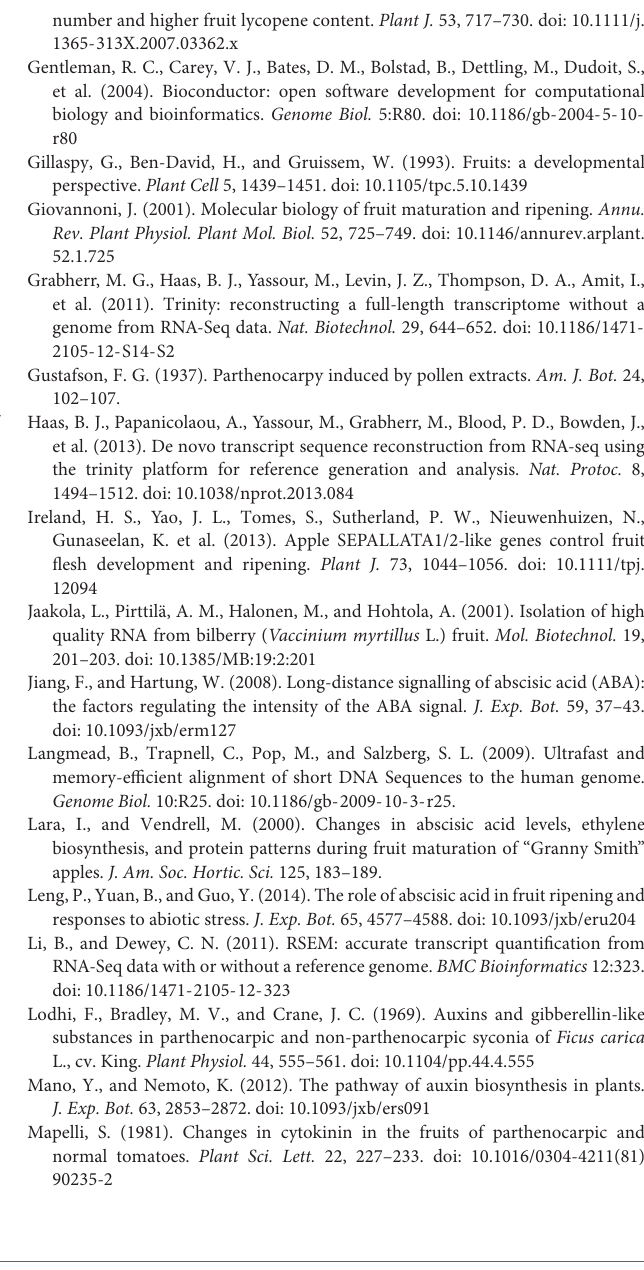
up-representation; green, down-representation. 8WAP–9WAP, 8–9 weeks after pollination; 10, 60, 100%, ripening stage. FIGURE S5 | Heat map of the log2-normalized transcriptomic representation profiles of 19 auxin metabolism-related gene transcripts in parthenocarpic and pollinated fruit inflorescence and pulp. Red, up-representation; green, down-representation. 8WAP–9WAP, 8–9 weeks after pollination; 10, 60, 100%, ripening stage. FIGURE S6 | Heat map of the log2-normalized transcriptomic representation profiles of 13 ethylene metabolism-related gene transcripts in parthenocarpic and pollinated fruit inflorescence and pulp. Red, up-representation; green, down-representation. 8WAP–9WAP, 8–9 weeks after pollination; 10, 60, 100%, ripening stage. TABLE S1 | Number of down- and upregulated enriched molecular functions in pollinated and parthenocarpic fig inflorescence and